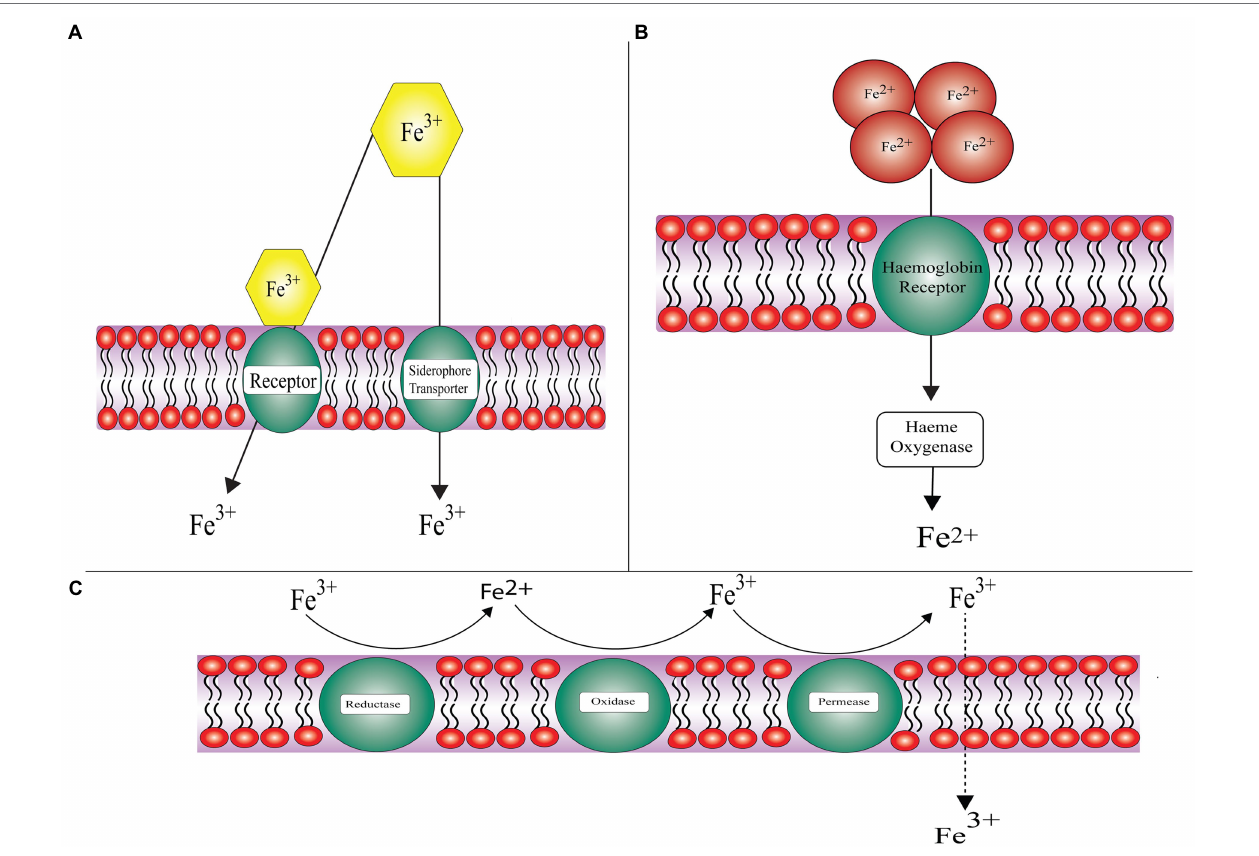
FIGURE 2 | General approaches employed by pathogenic fungi for acquiring iron (A) Siderophore uptake system: acquisition of iron from siderophores and xenosiderophores, (B) Hemoglobin utilization: chelation of iron from heme proteins and hemoglobin, and (C) Reductive system: subject to assimilating iron through redox reaction and further transportation into cytoplasm dictated by iron